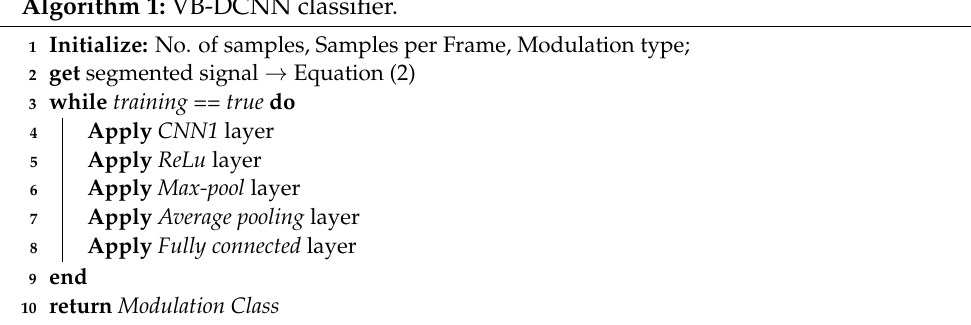
Algorithm 1: VB-DCNN classifier.